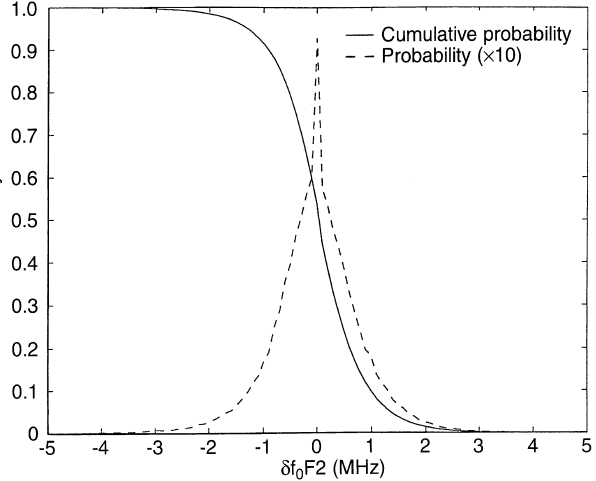
Fig. 2. The distribution of all (cid:100) f o F 2 values observed at Slough for calendar years 1967–1989. The dashed line is the occurrence probability of the (cid:100) f o F 2 value given by the horizontal axis, whereas the solid line is the cummulative probability distribution of (cid:100) f o F 2 exceeding the value on that axis. Note the vertical scale is for the cummulative probability distribution and also applies, but divided by a factor of 10, for the probability